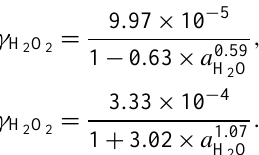
value of γ H , similar to γ PAA , shows a positive cor- 2 O 2 relation with RH on ADS particles and a negative cor- relation with RH on ATD particles. By taking the aver- age of γ values at low and high mass loading, γ H on ADS increases from (1.10 ± 0.31) × 10 − 4 at 3 % RH to (2.44 ± 0.69) × 10 − 4 at 90 % RH and the γ H ATD decreases from (3.11 ± 0.34) × 10 − 4 at 3 % RH to (0.87 ± 0.06) × 10 − 4 at 90 % RH. Although the values of γ H at low and high mass loading are not identical, all 2 O 2 γ H values on ADS show a positive correlation with RH, 2 O 2 and all γ H values on ATD show a negative correlation with 2 O 2 RH. A es for ADS l and ADS h is 6.1 and 10.9 cm 2 , respec- tively; A es for ATD l and ATD h is 6.4 and 11.2 cm 2 , respec-